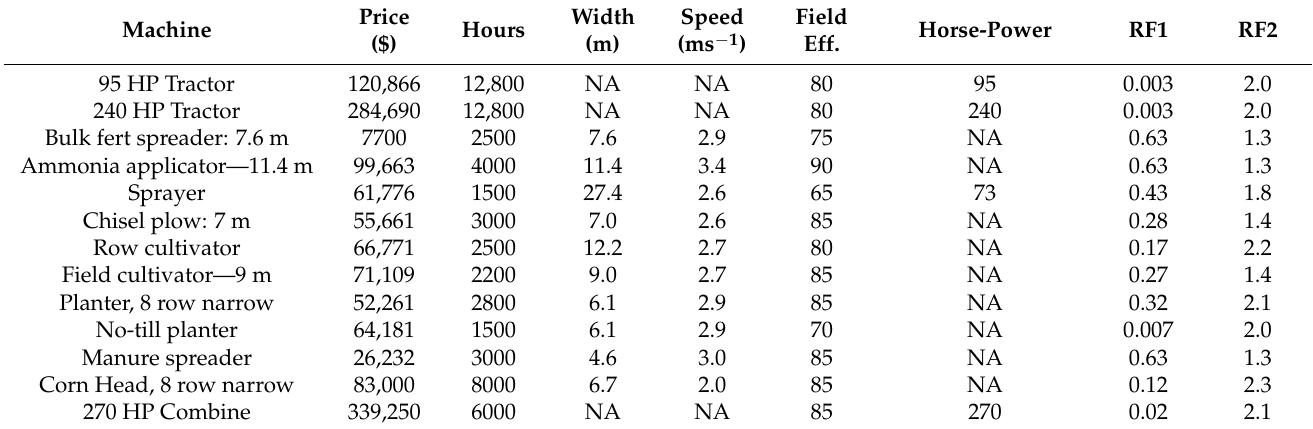
Table 3. Characteristics of field machines after FEM calibration *.